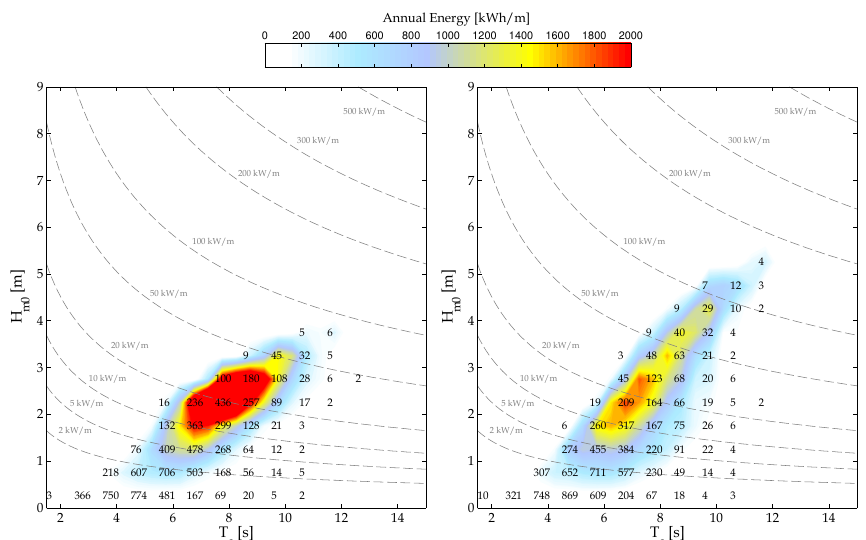
Figure 14. Characterisation of the yearly average wave energy in terms of H m 0 and T e : on the left site HS5 and on the right site HS6. The colour scale represents annual energy per metre of wave front (in MWhm − 1 ). The numbers within the graph indicate the occurrence of sea states (in number of hours per year).